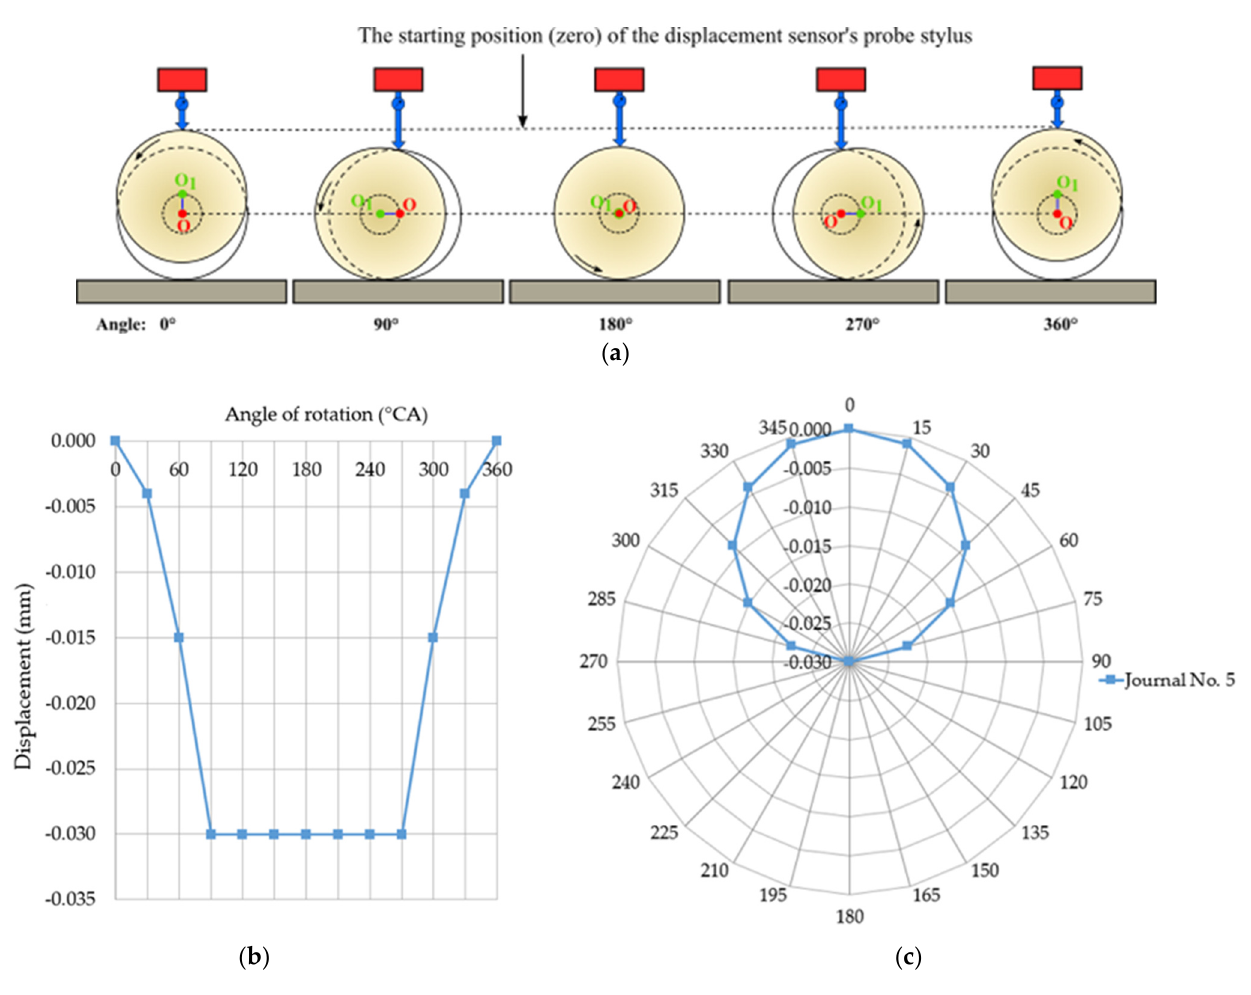
Figure 1. Indications of the sensor when measuring journal displacement over the full range of crankshaft rotation from 0° to 360° recorded at a constant heigh position of the support ( a ); limits shown in Cartesian coordinates ( b ); limits shown in polar coordinates ( c ) [17–19].